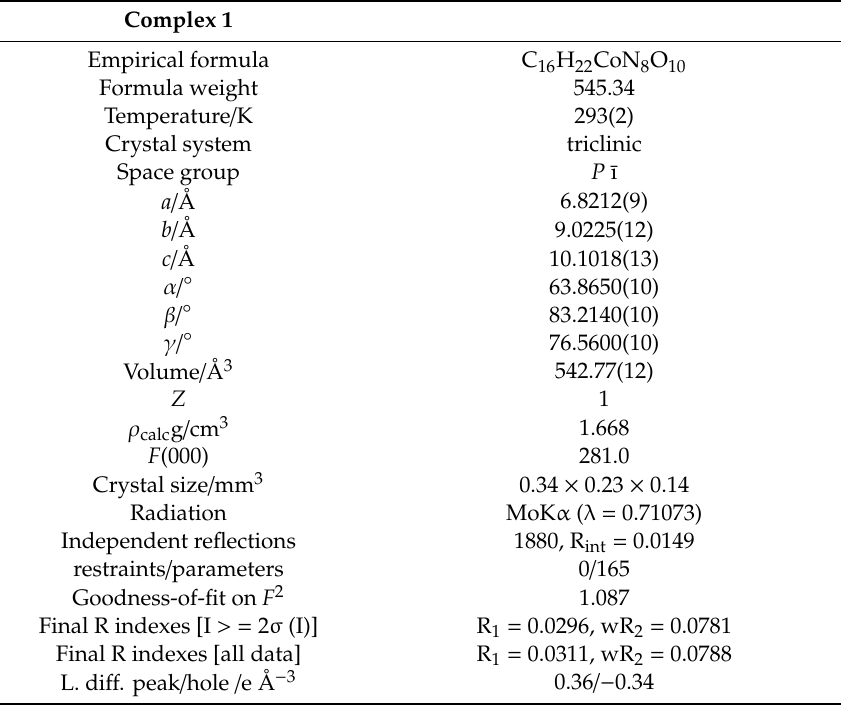
Table 1. Crystal data and structure refinement for complex 1